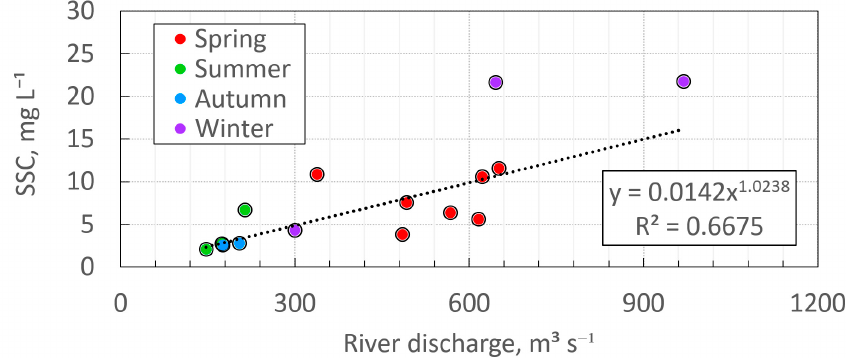
Figure 5. Relationship between SSC and Nemunas River discharge.